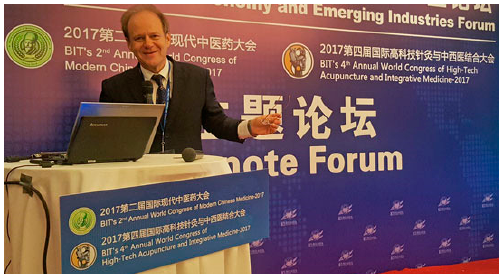
Figure 2. Professor Gerhard Litscher, initiator and chairman of the four (2014–2017) World Congresses of High-Tech Acupuncture and Integrative Medicine in China.